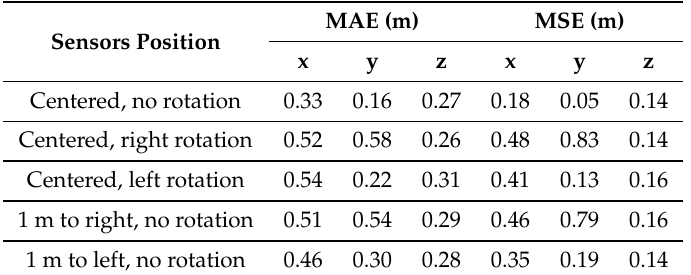
Table 10. Errors of the coordinates estimation module by sensors